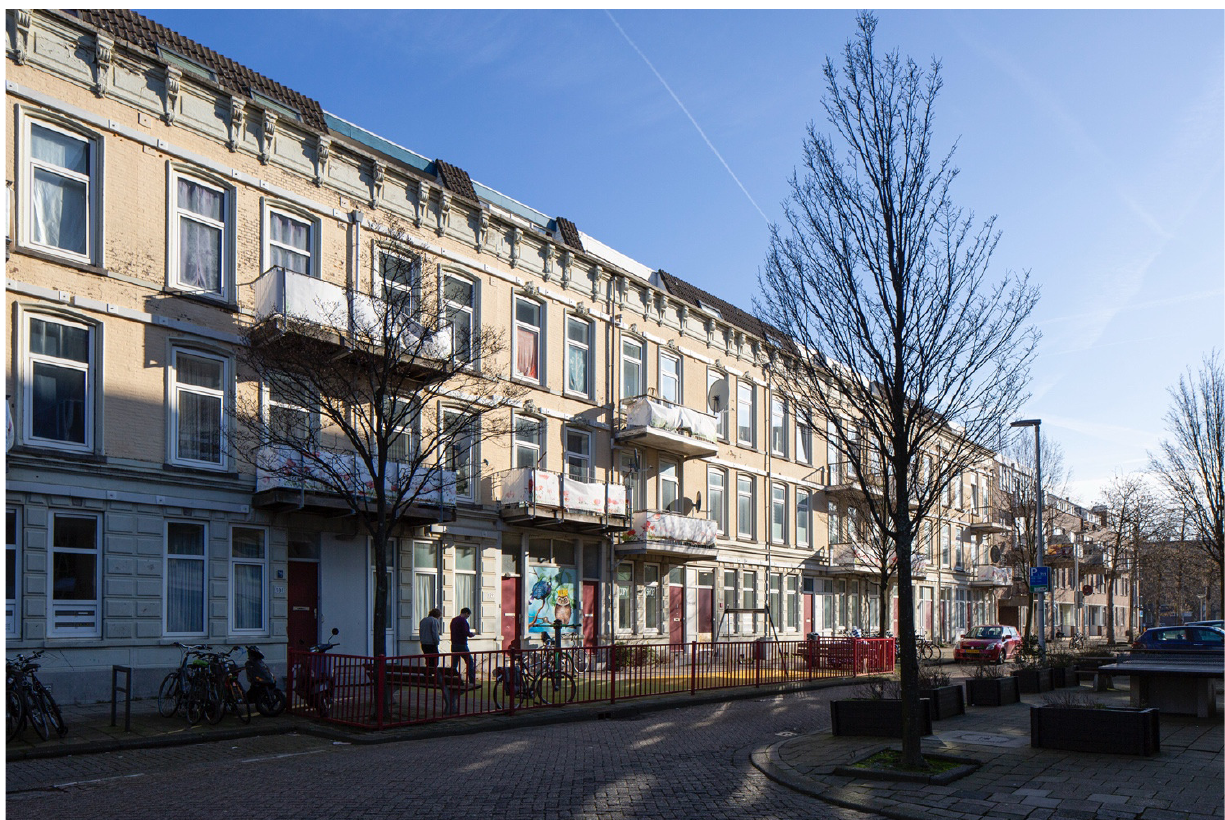
Figure 1. Pension